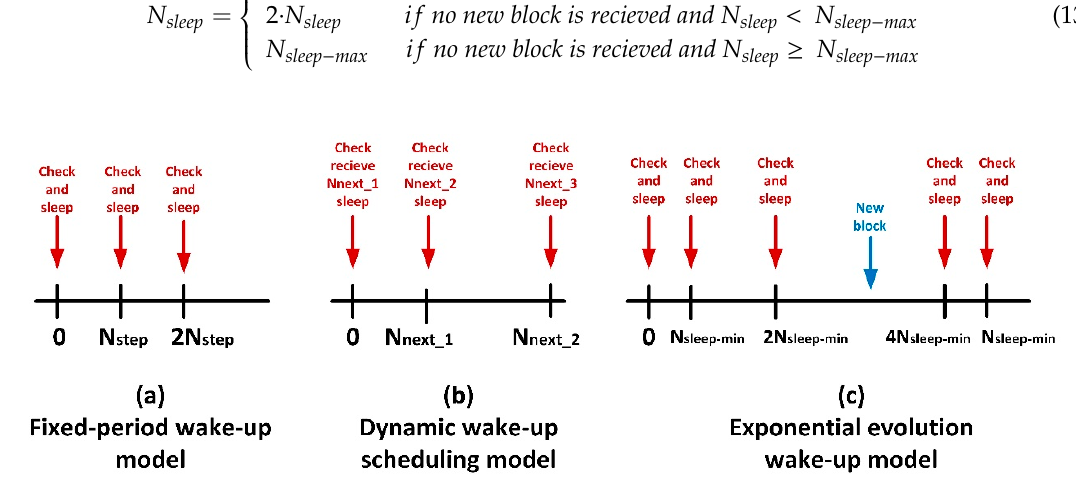
ff erent behaviour